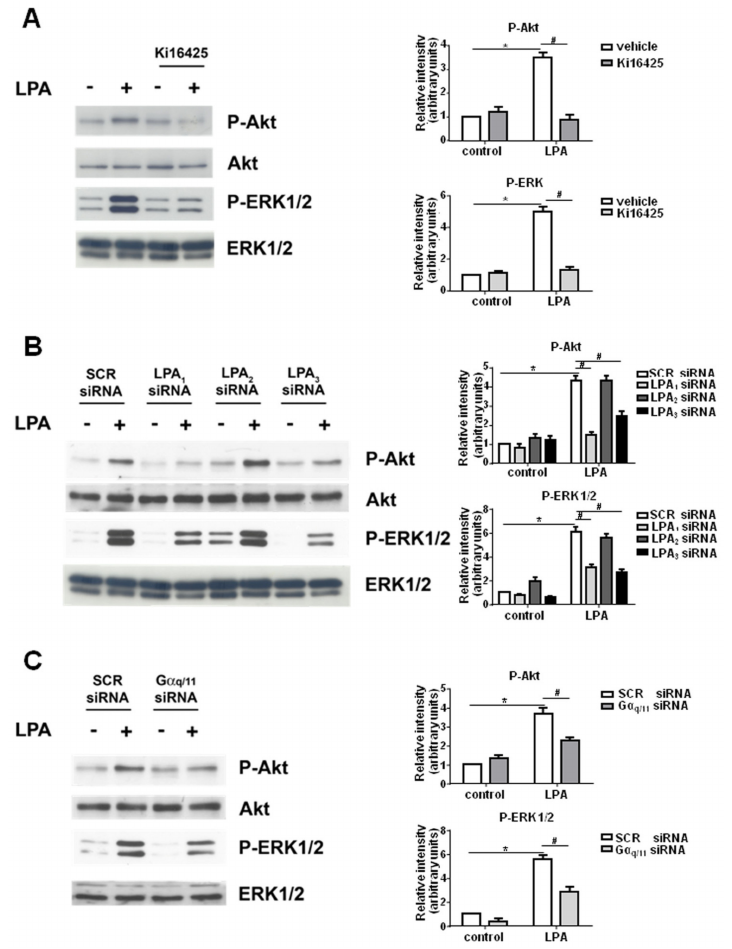
Figure 6. LPA-induced activation of ERK1/2 and Akt requires LPA 1 /LPA 3 and G α q/11. Overnight serum-starved C2C12 myoblasts were pre-incubated for 30 min: in the presence or absence of 2.5 µ M Ki16425 ( A ); transfected with scrambled (SCR-) or with specific siRNAs for individual LPA receptors ( B ); or transfected with SCR- or G α q/11-siRNA ( C ), before being stimulated with 100 nM LPA for 5 min. Left panels: Western blot analysis performed using specific anti-phospho-ERK1/2 and anti-phospho-Akt antibodies in myoblast cell lysates. A blot representative of three independent experiments is shown. Right panels: Band intensity was quantified by densitometric analysis and normalized to the expression of total ERK1/2 and total Akt, respectively. LPA activates ERK1/2 and Akt in a statistically significant manner by Student’s t test (* p < 0.05); the effect of LPA 1/3 inhibition by Ki16425 ( A ); the effect of LPA 1 or LPA 3 down-regulation ( B ); or the effect of G α q/11